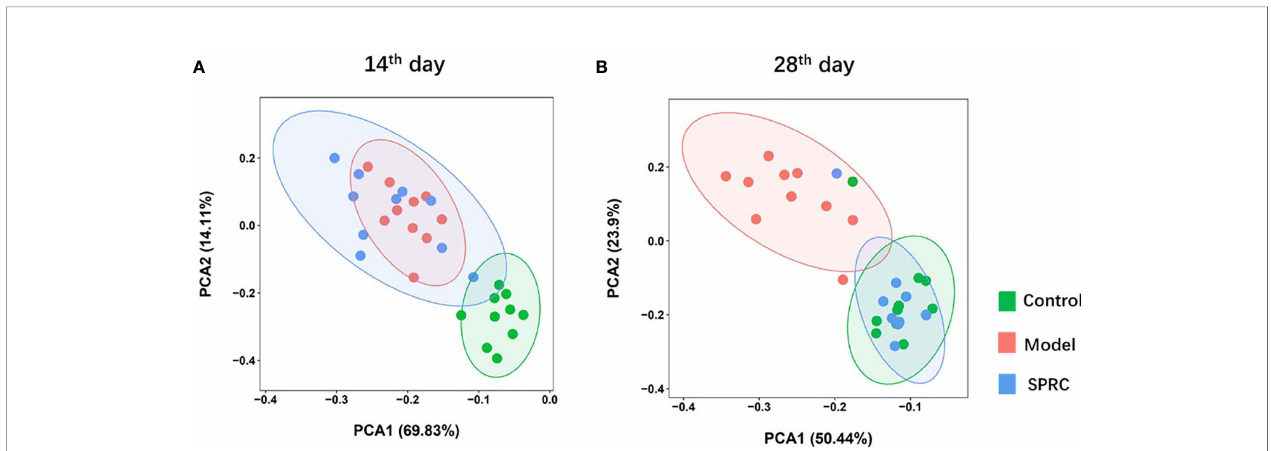
FIGURE 4 | SRPC reshaped the gut microbiota of AIA rats. Principal component analysis (PCA) plot based on the OTU matrix of rat fecal samples from the Control, Model, and SPRC groups on the 14 th day (A) and 28 th day (B)